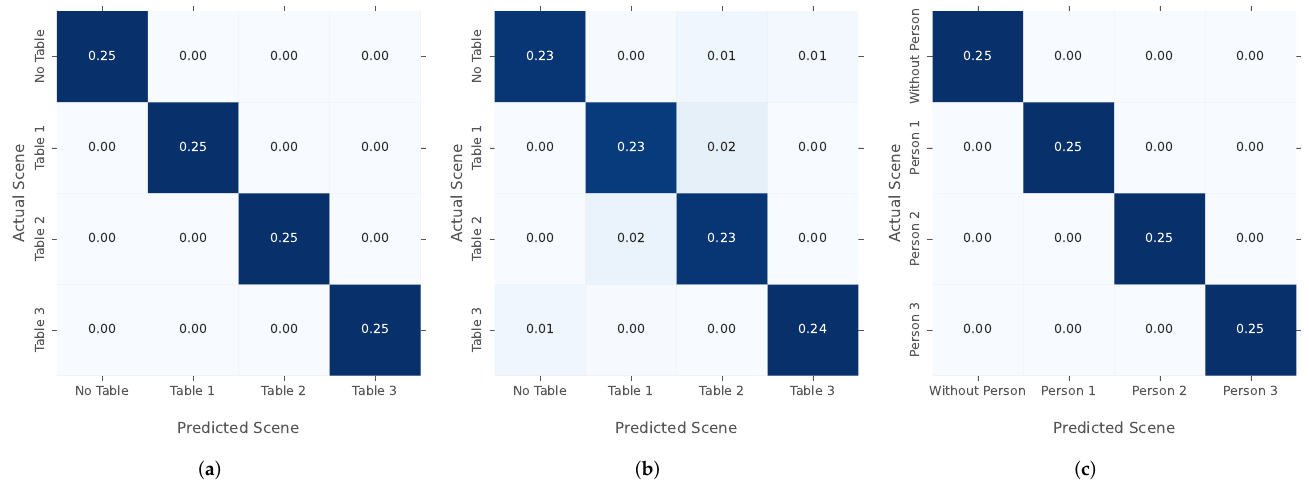
Predicted Scene